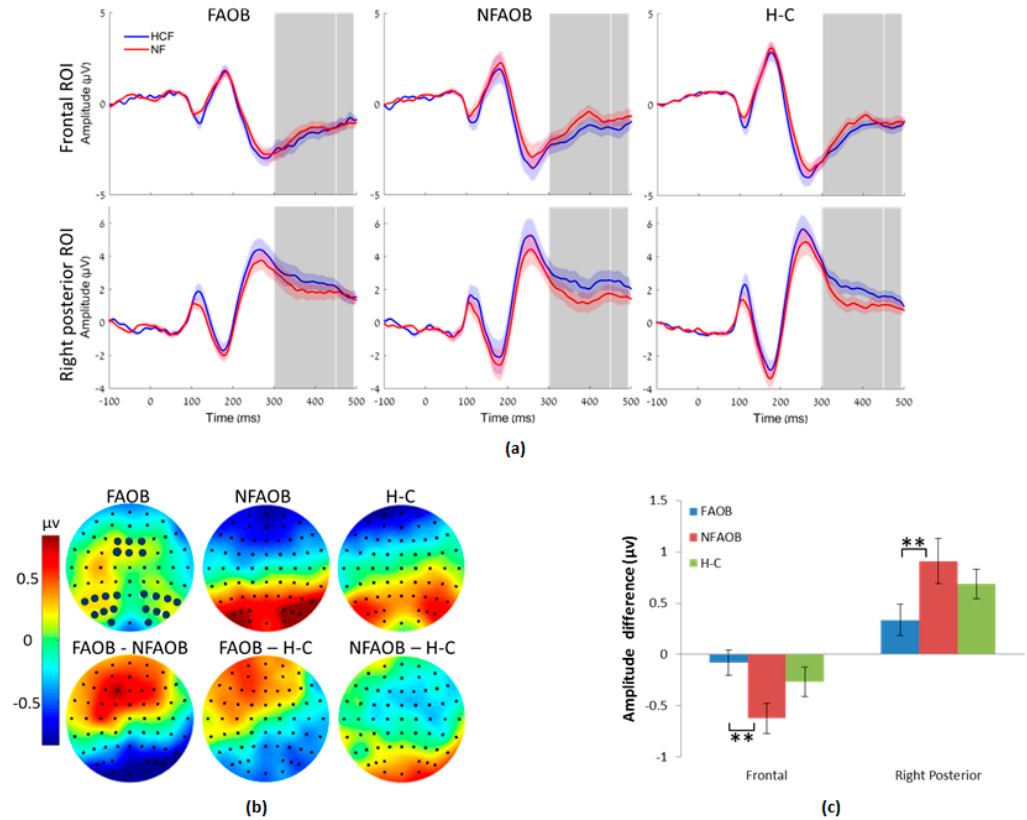
Figure 4. Brain potentials in response to food cues. ( a ) Event related potential curves in the FAOB, NFAOB and H-C groups, following HCF compared with NF images, in the frontal and right posterior ROI (no group di ff erences in the left posterior ROI, hence not shown). Curve’s shades mark SEM; TOIs (LPPa, LPPb) are marked in gray. ( b ) Topographic plots of mean group amplitudes (upper row) and group contrasts (lower row) during the LPPb. Electrodes of the di ff erent ROI are marked in dark blue ( c ) Mean and SEM of the same in the frontal and right posterior ROI. ** p ≤ 0.01. FAOB: overweight and obese with food addiction. NFAOB: overweight and obese without food addiction. H-C: healthy controls. HCF: high-calorie food. NF: nonfood. ROI: region of interest. SEM: standard error of mean. TOI: times of interest. LPP: late positive